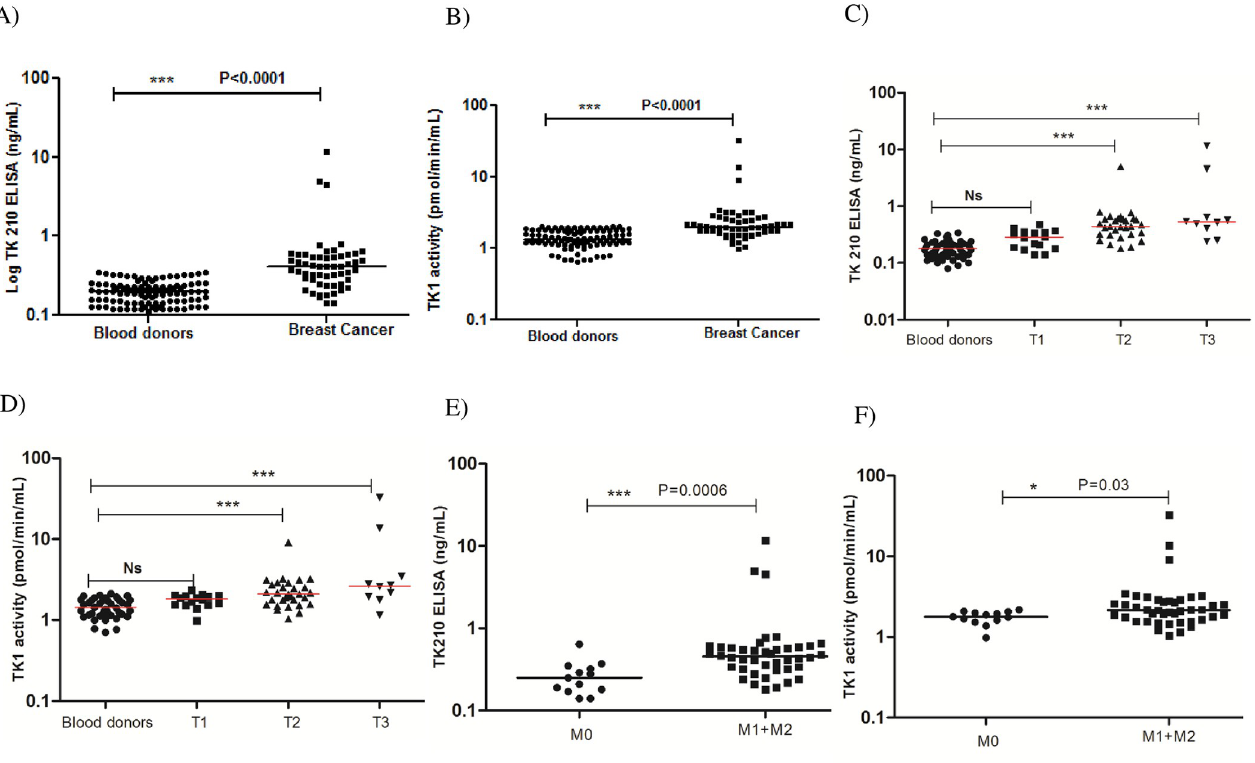
Fig 7. Distribution of TK1 protein and TK1 activity values in sera from patients with breast cancer. (A) TK1 protein values in sera from blood donors ( ● ) and patients with breast cancer ( ■ ). (B) TK1 activity levels in sera from blood donors ( ● ) and patients with breast cancer ( ■ ). (C) Comparison of TK1 protein levels in sera from blood donors ( ● ), T1 ( ■ ), T2 ( ▲ ) and T3 ( ▼ ) breast cancer patients. (D) Comparison of TK1 protein levels in sera from blood donors ( ● ), T1 ( ■ ), T2 ( ▲ ) and T3 ( ▼ ) breast cancer patients. (E) Comparison of TK1 protein levels in patients without metastasis (M0) ( ● ) and patients with metastasis (M1 +M2) ( ■ ). (F) Comparison of TK1 activity values in patients without metastasis (M0) ( ● ) and patients with metastasis (M1+M2) ( ■ ). The error bars denote median.